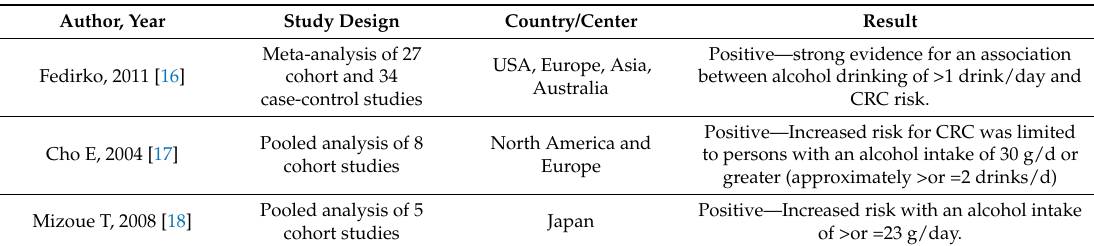
Table 2. Summary of major epidemiological studies examining the association of Alcohol consumption with CRC.